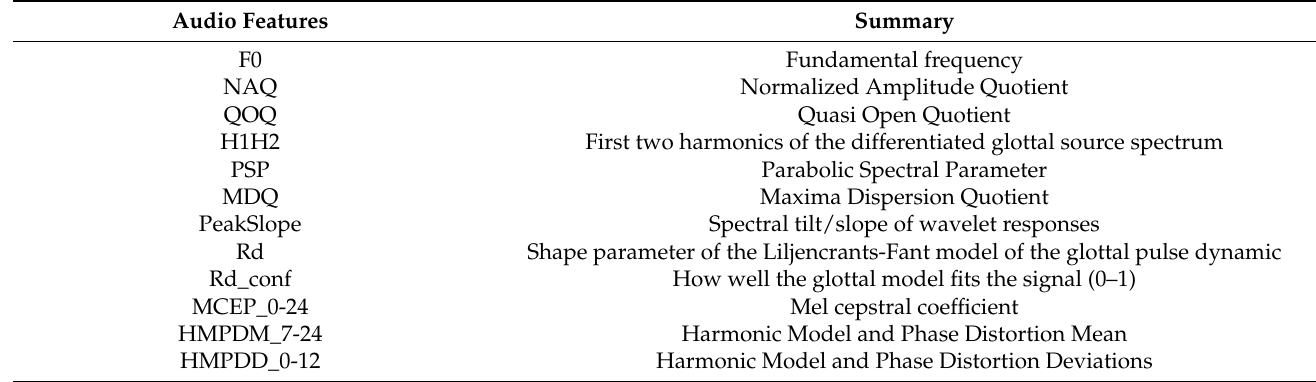
Table 3. Audio features used in this